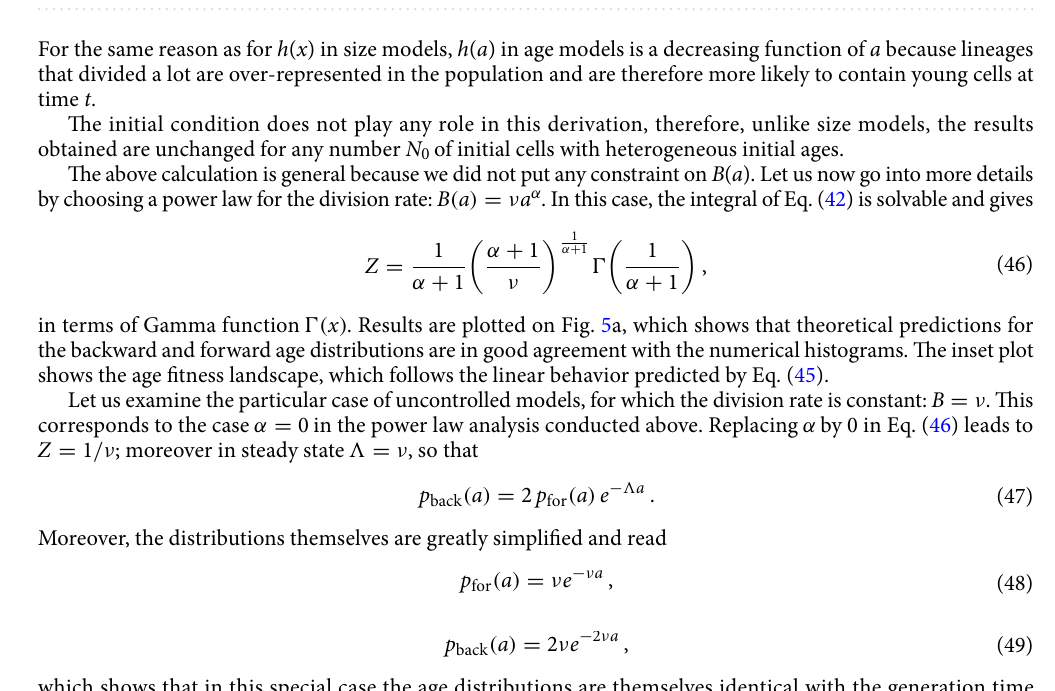
Figure 5. Age distributions and age fitness landscape for constant individual growth rate ν ( a ) and age fitness landscapes for fluctuating ν ( b ). In ( a ), the forward (resp. backward) age distribution is shown with orange filled histogram (resp. blue empty histogram). The red and green curves are the corresponding theoretical predictions. The inset plot shows the age fitness landscape (purple crosses) and the theoretical linear law (green). The horizontal black dashed-line represents the population growth rate (cid:31) . The simulation was conducted with B ( a ) = ν a α , ν = 1 , α = 2 , t = 12 and N 0 = 1 . In ( b ), the age fitness landscapes are shown for models without (purple dots) and with (pink squares) mother-daughter correlations in individual growth rates. The green line of slope − (cid:31) fits well the purple dots. For both models, we chose a Gaussian distribution for (cid:31) , of standard deviation σ ν , and centred either on the mother growth rate ν ′ for models with correlations or on a constant mean growth rate ν m for uncorrelated models. The simulation was conducted with ν m = 1 , σ ν = 0.4 , α = 5 , t = 12 and N 0 = 1